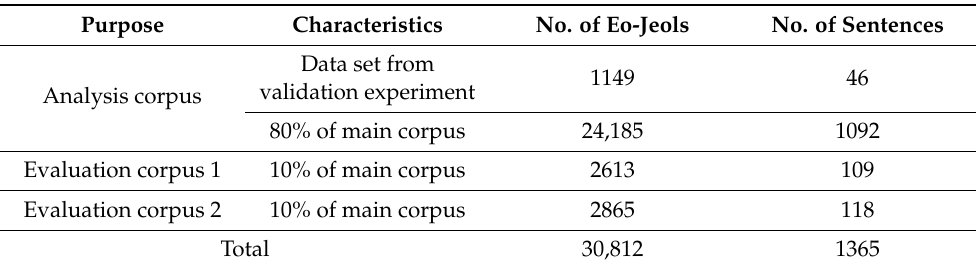
Table 8. Constructed corpus with consistent prosodic